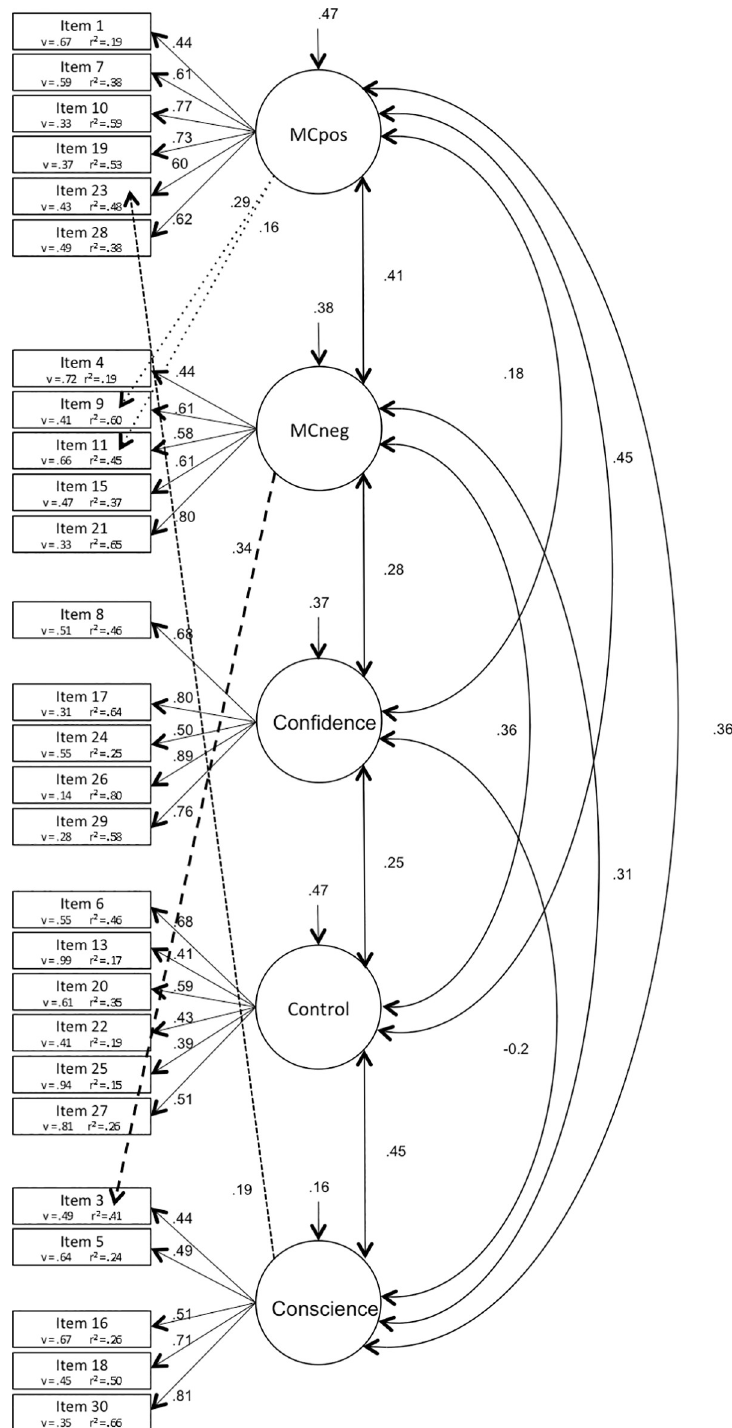
Fig 2. Covariate factor model of MCQ-Af (27questions). Numbers arrowed on latent variables represent variance, v = variance; r 2 = squared multiple correlations.